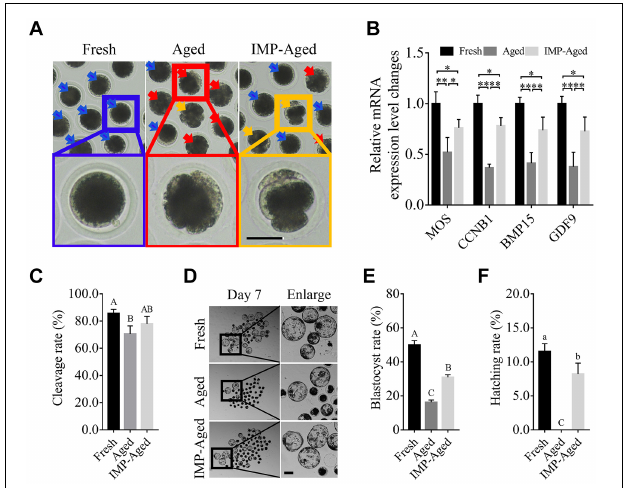
FIGURE 1 | IMP supplementation enhanced the development of porcine parthenogenetic embryos derived from aged oocytes. (A) Representative images of oocytes in fresh, aged, and IMP-treated aged groups. Normal/abnormal cytoplasm/spontaneous parthenogenetic activated oocytes were labeled with blue/red/orange arrows. Scale bar = 50 µ m. (B) Differential gene expression in fresh, aged, and IMP-treated aged oocytes. Gene expression was detected in oocytes after 24 h of aging. R = 3. * P < 0.05; ** P < 0.01. (C) Cleavage rate of parthenogenetic activated embryos derived from fresh ( N = 199), aged ( N = 216), and IMP-treated aged ( N = 218) group. R = 4. Significant differences are represented by different capital letters ( P < 0.01). (D) Representative images of parthenogenetic embryo development on day 7 derived from fresh, aged, and IMP-treated aged groups. Scale bar = 100 µ m. (E) Blastocyst formation rate on day 7 in the fresh, aged, and IMP-treated aged groups. Significant differences are represented by different capital letters ( P < 0.01). (F) Hatching rate on day 7 in the fresh, aged, and IMP-treated aged groups. No hatched blastocysts were observed in aged group. Significant differences are represented by different lower-case ( P < 0.05) and capital ( P < 0.01) letters.